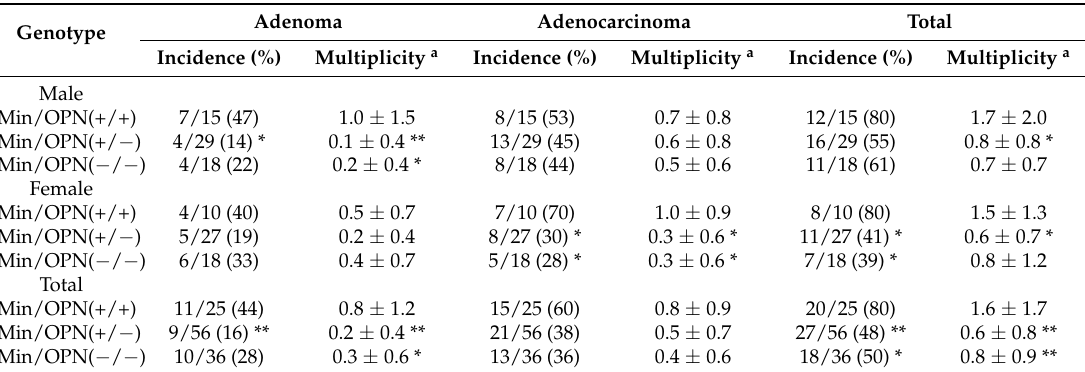
Table 2. Incidence and multiplicity of colon tumors in OPN-deficient Min mice.